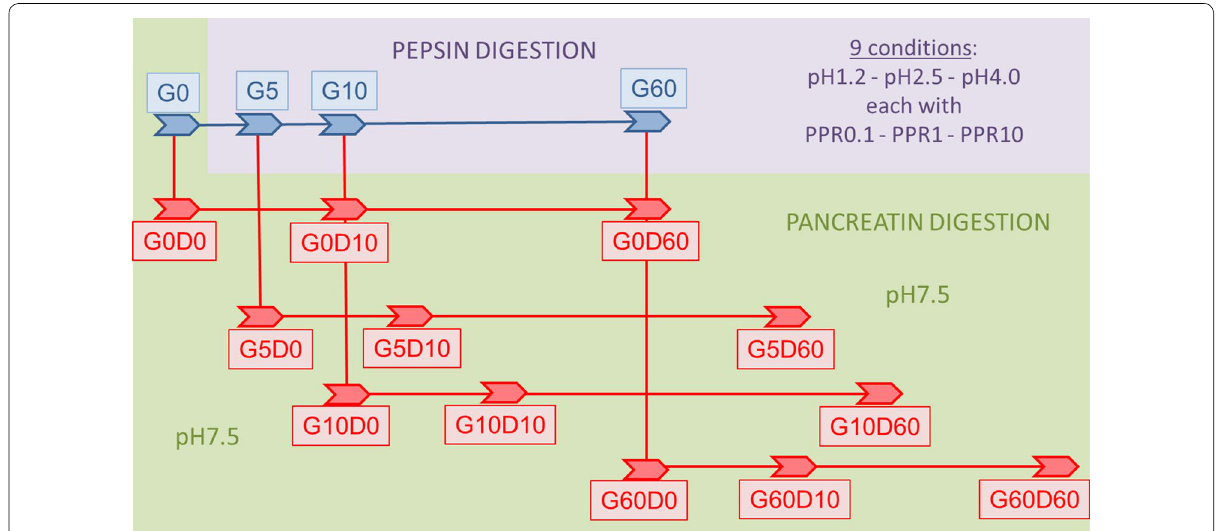
Fig. 1 A schematic representation of the sequential sampling during the combined gastric and duodenal digestion protocol. G stands for gastric, D for duodenal. The numbers indicate the time at which samples were taken in minutes. G0 and G0D0 samples have not been exposed to acidic pH. In total 9 different combinations of pH and pepsin‑to‑protein ratios were tested in the gastric phase. In combination with the duodenal phase per molecule a total of 144 samples (4 gastric plus 3 4 duodenal times 9 conditions) were analyzed by SDS‑PAGE and ×